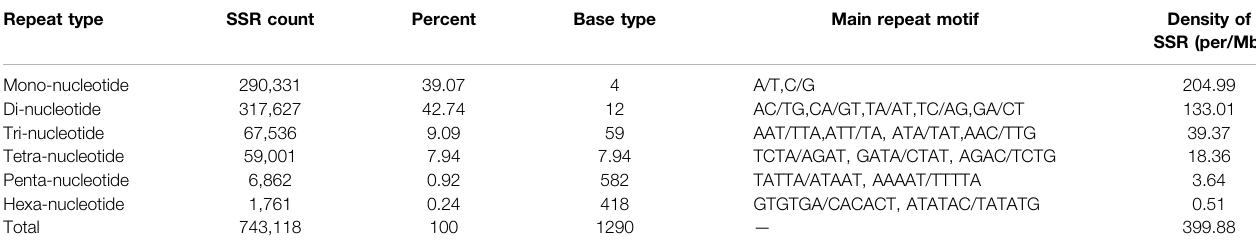
TABLE 2 | Distribution characteristics of SSR motifs in the genome of Schizothorax biddulphi . Repeat type